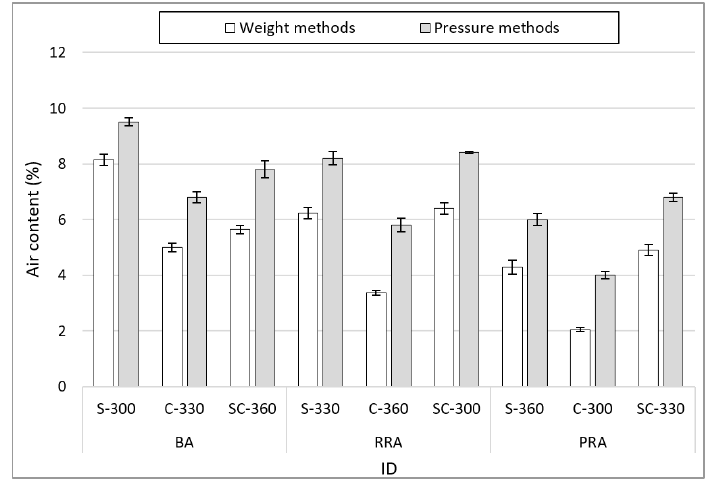
Figure 7. Air content of fresh concrete.